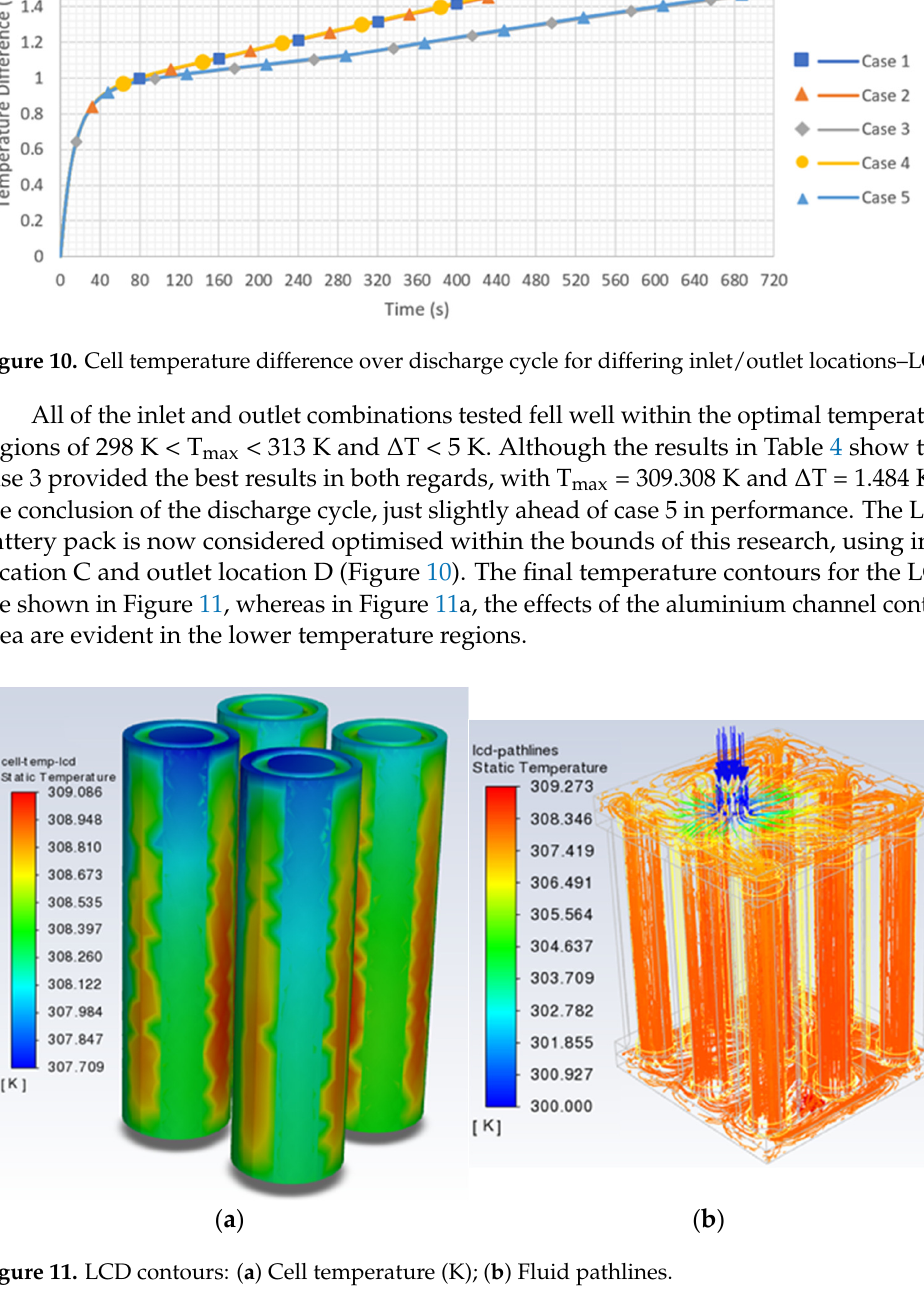
17 of 28 Table 4. Thermal performance of location combinations at t =720s–LCD. Location Combination